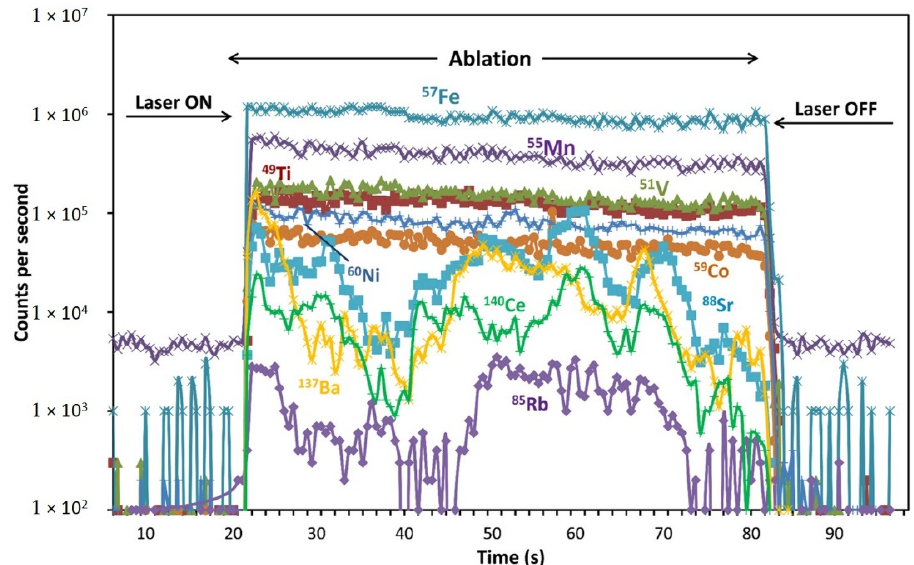
Figure 8. An example of time-resolved LA-ICP-MS depth profile (dunite sample SN-N6; resorbed Spl grain; beam diameter is 35 μ m) showing uneven Rb (isotope 85 Rb), Sr ( 88 Sr), Ba ( 137 Ba) and Ce ( 140 Ce) distribution across spinel grain volume due to the incorporation of silicate material into the resorbed spinel grain. From the left, the background count is 22 s (not shown completely), followed by 60 s of the ablation time, which is integrated and by 40 s of the wash-out time (not shown completely). A few selected isotopes with even distribution (which are not abundant in silicate glass material) are shown for comparison.